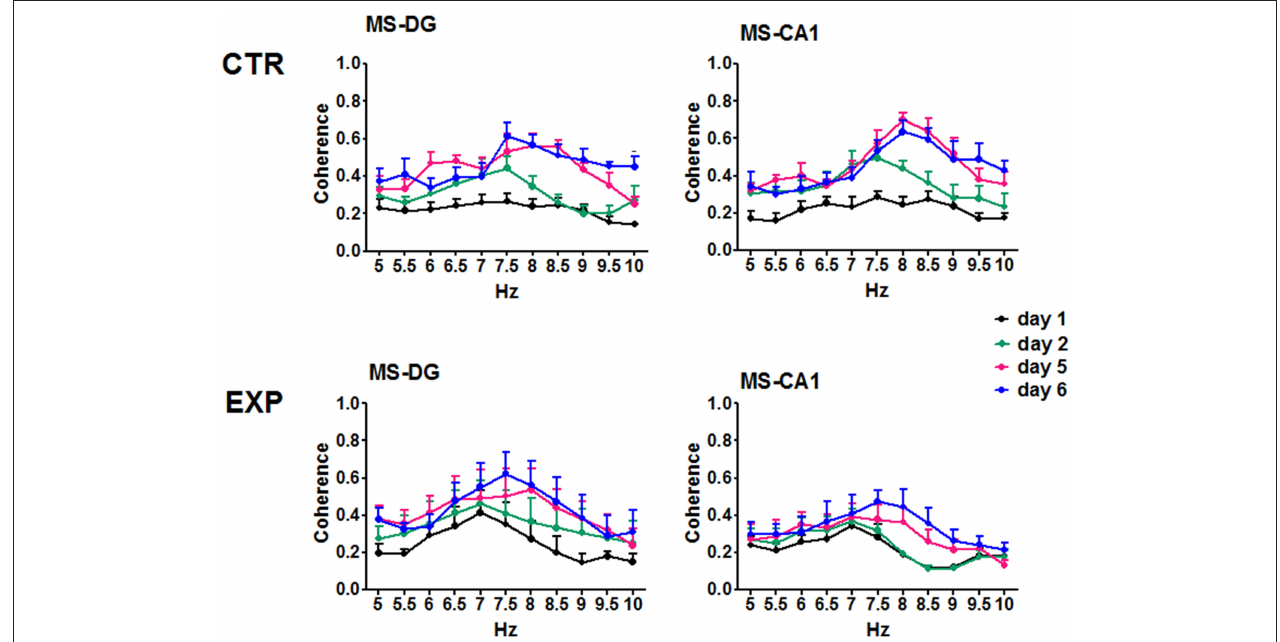
FIGURE 8 | Coherences of the EEG recorded in the MS, DG and CA1 in the two groups across training days. For the CTR group the ANOVA was significant only considering the days 1, 2, 5, and 6. Only CTR group showed increased coherence between MS-DG and MS-CA1. Mean ± SEM. Significant differences are listed in Table 3 . p < 0.05 .